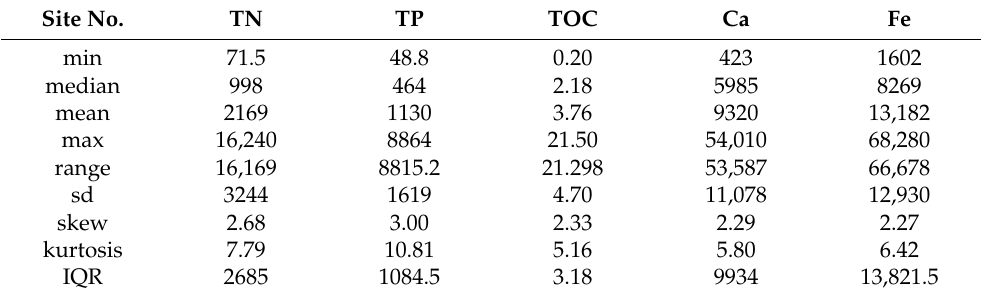
Table 3. The descriptive statistics concentrations of chosen elements (mg · kg − 1 ) and TOC (% d.m.). Site No. TN TP TOC Ca